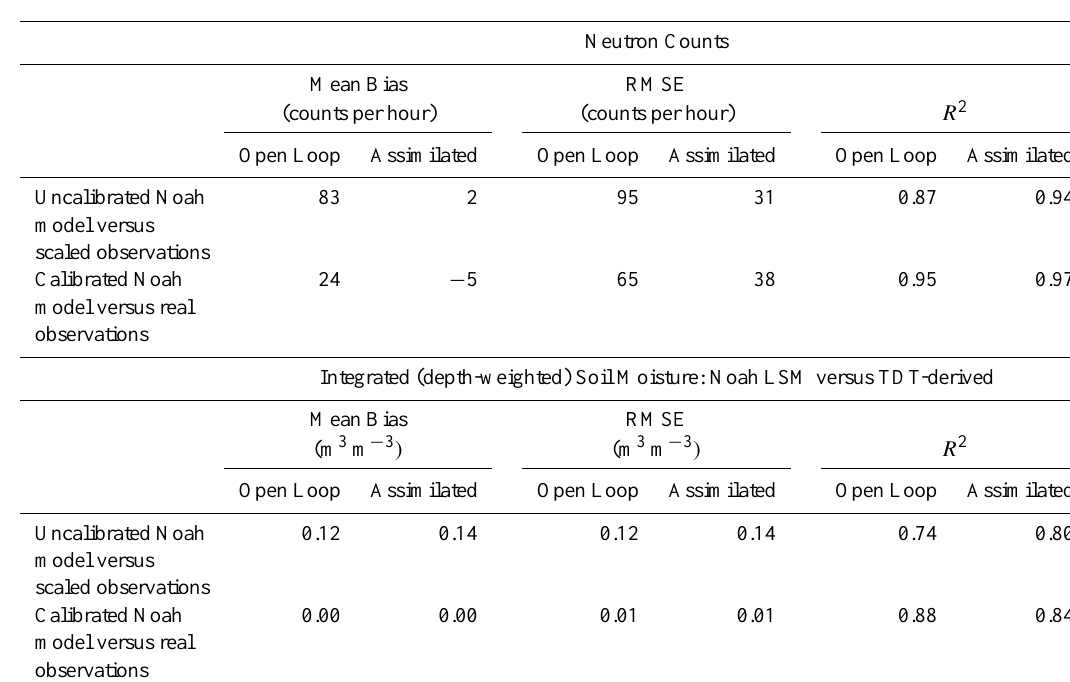
Table 3. Values of criteria that characterize the comparison between the different time series illustrated in Figs. 9 and